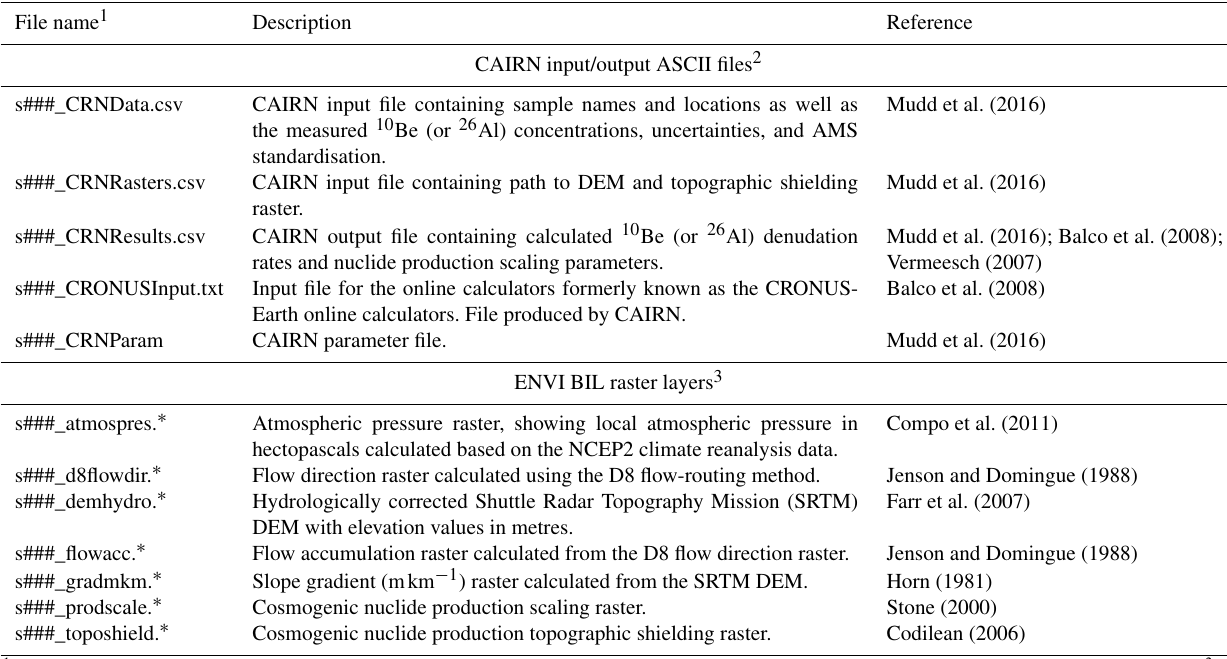
Table 2. Description of CRN data files available as part of .zip